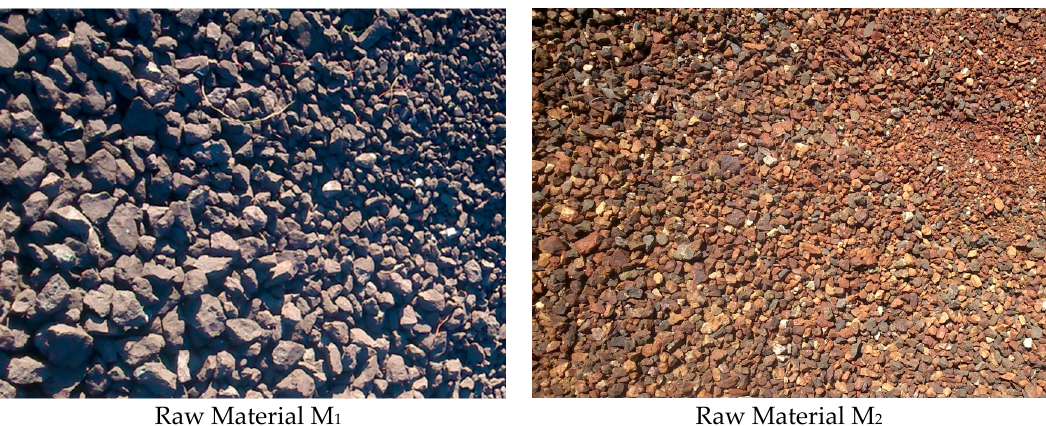
Figure 1. Outcroppings of the materials in Jrissa mining site.